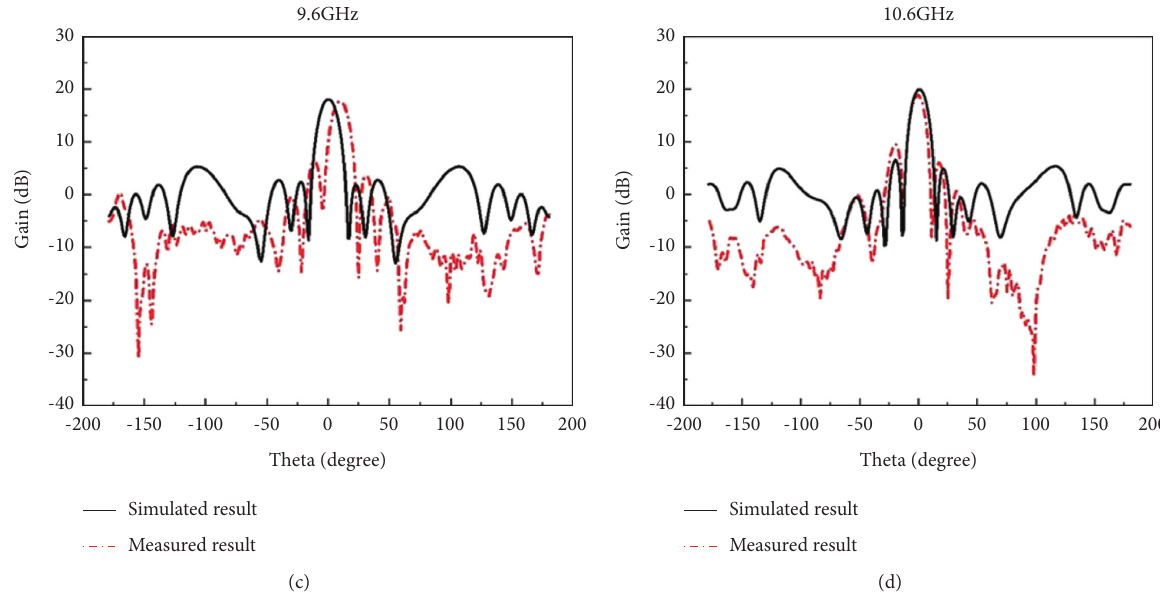
Figure 10: Measured radiation property; (a) radiation performance measured environment; (b) measured S11; (c) comparison between measured and simulated gain at 9.6GHz; (d) comparison between measured and simulated gain at